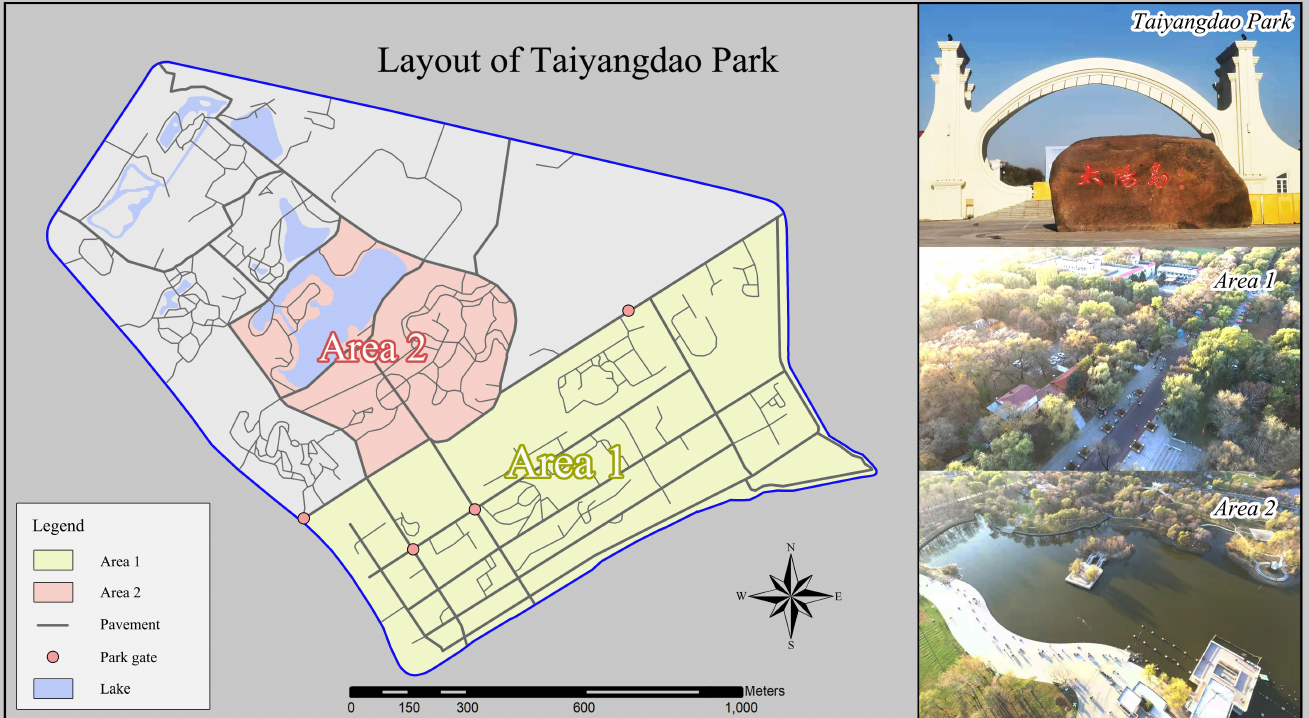
Figure 4. Spatial layout and aerial photographs of Taiyangdao Park.